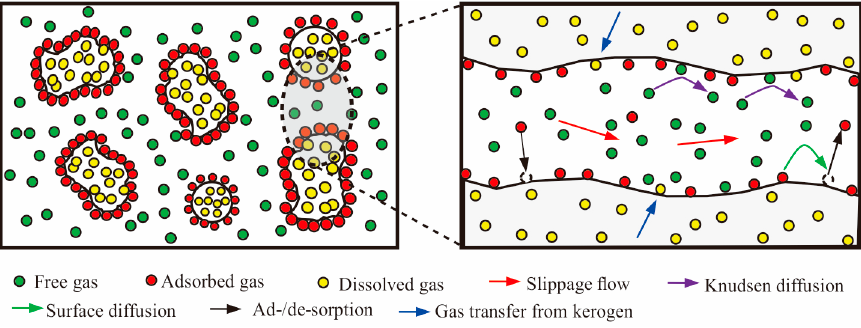
Figure 1. Storage form and flow mechanism of shale gas in nanopores.